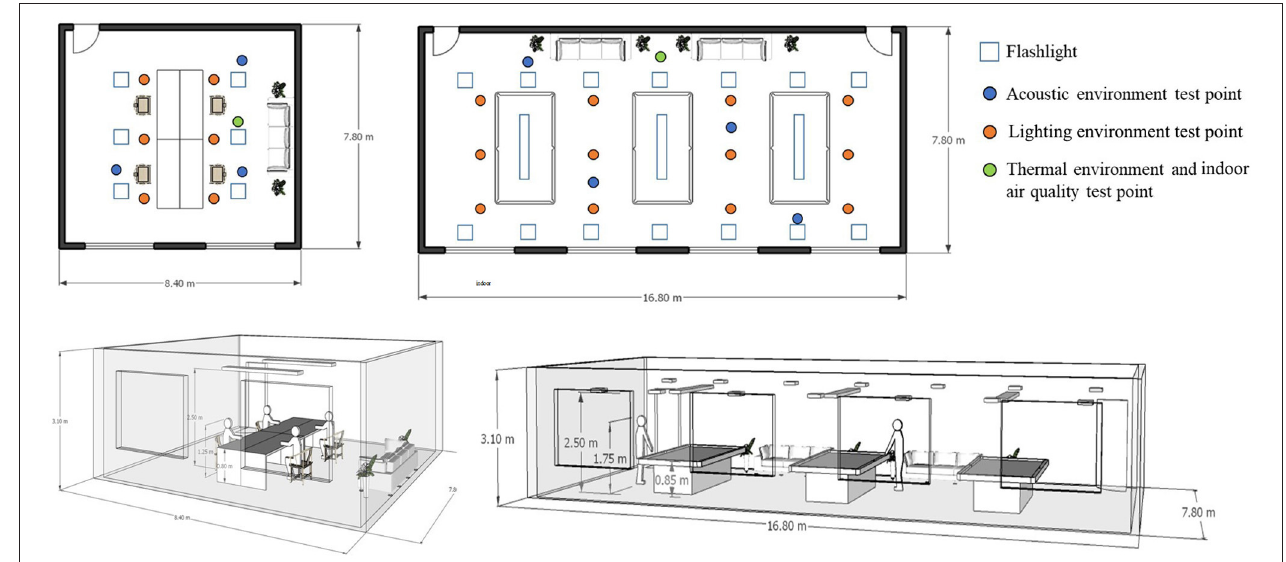
FIGURE 1 | Layout of the test points.